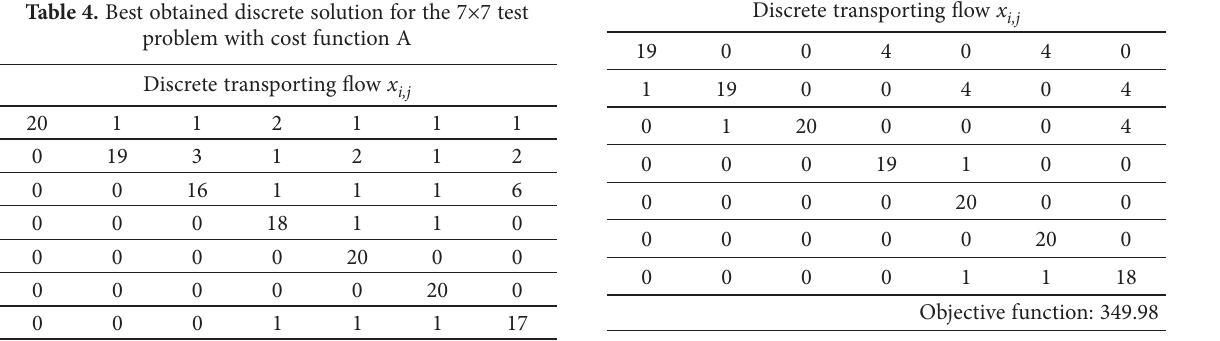
Table 6. Best obtained discrete solution for the 7×7 test problem with cost function B Discrete transporting flow x i,j